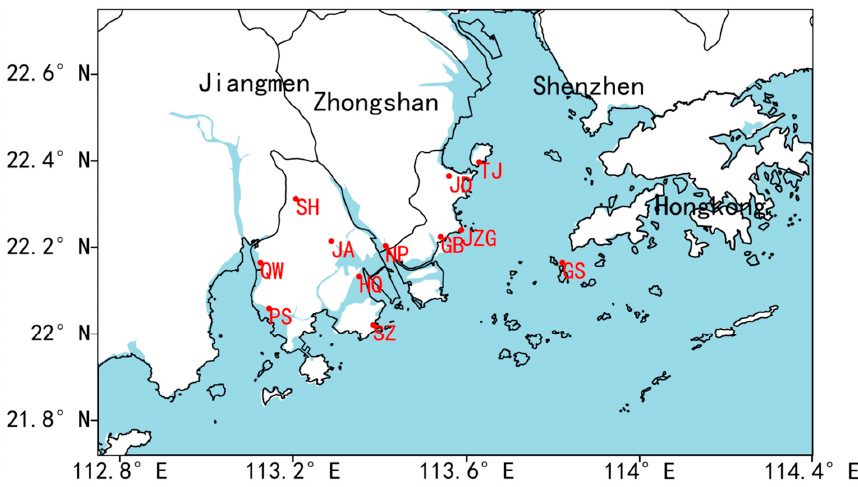
Figure 1. The map of the GBA megalopolis with the red circles denoting locations of measurement sites over Zhuhai (GS: GuiShan Island; QW: QianWu; JD: JinDing; SZ: SanZao; NP: NanPing; PS: PingSha; JZG: JiuZhouGang; TJ: TangJia; GB: GongBei; JA: JingAn; SH: ShangHeng; HQ: HongQi).